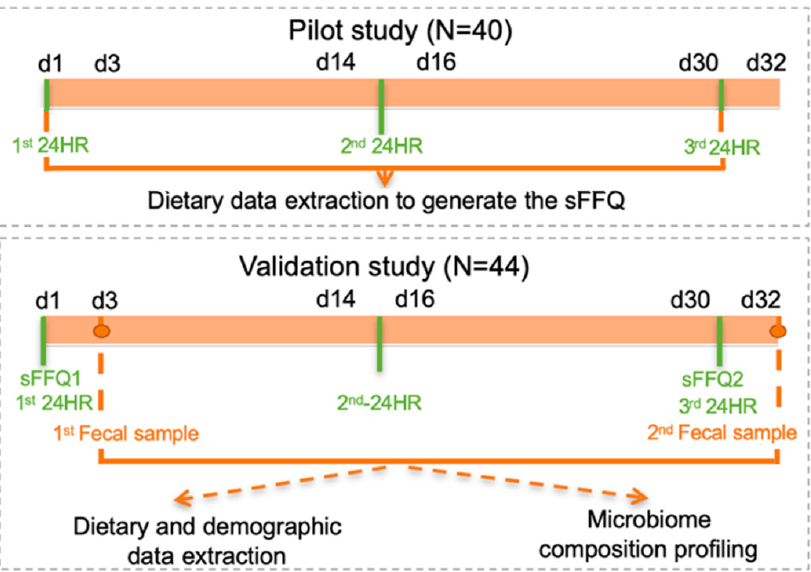
Figure 1. Study design. We first designed a pilot study to extract and quantify the dietary habits of our population. These data were then used to build a simplified food-frequency questionnaire (sFFQ). In the pilot study, participants were interviewed three times by trained staff members over a one-month period in a form of three dietary recalls (three 24HRs) (baseline, day 15, day 30), and in the validation study, they also underwent three 24HRs and were asked to complete two web-based sFFQs, one at baseline and the other a month later (first stool after completing each sFFQ). Participants provided a frozen stool sample on day 3 and day 32 for microbiome analysis.